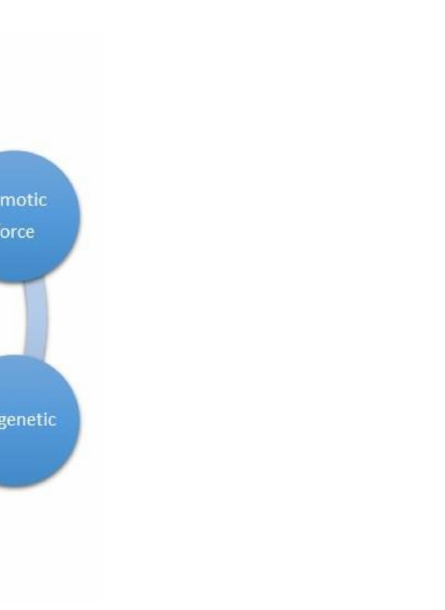
Figure 3. Potential mechanisms of Early Worsening of Diabetic Retinopathy development. GH/IGF1- growth hormone/insulin-like growth factor 1,VEGF- vascular endothelial growth